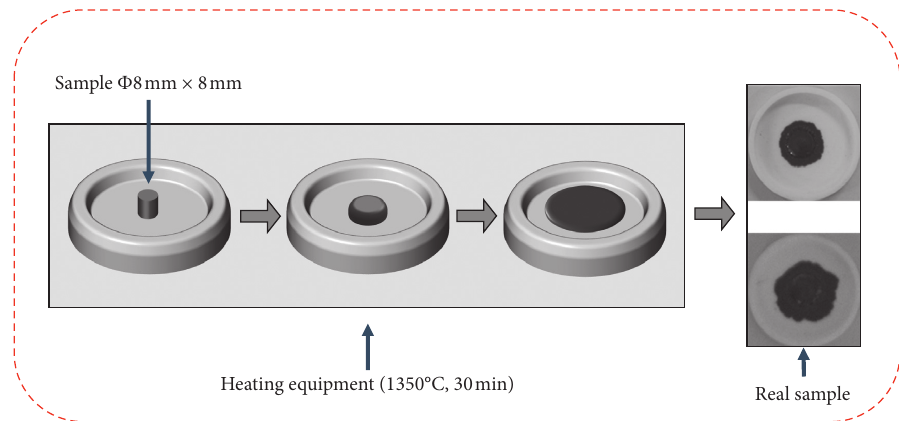
Figure 4: Diagrammatic chart of the fluidity of liquid-phase